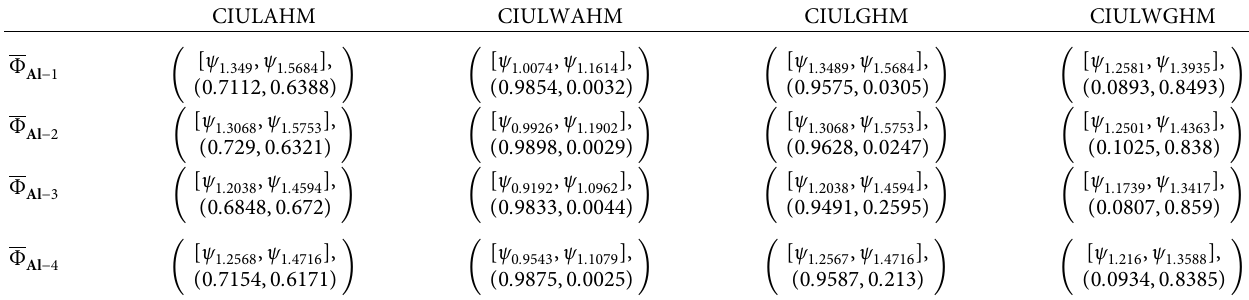
Table 15: Aggregated values of the alternatives by CIULAHM, CIULWAHM, CIULGHM, and CIULWGHM operators.